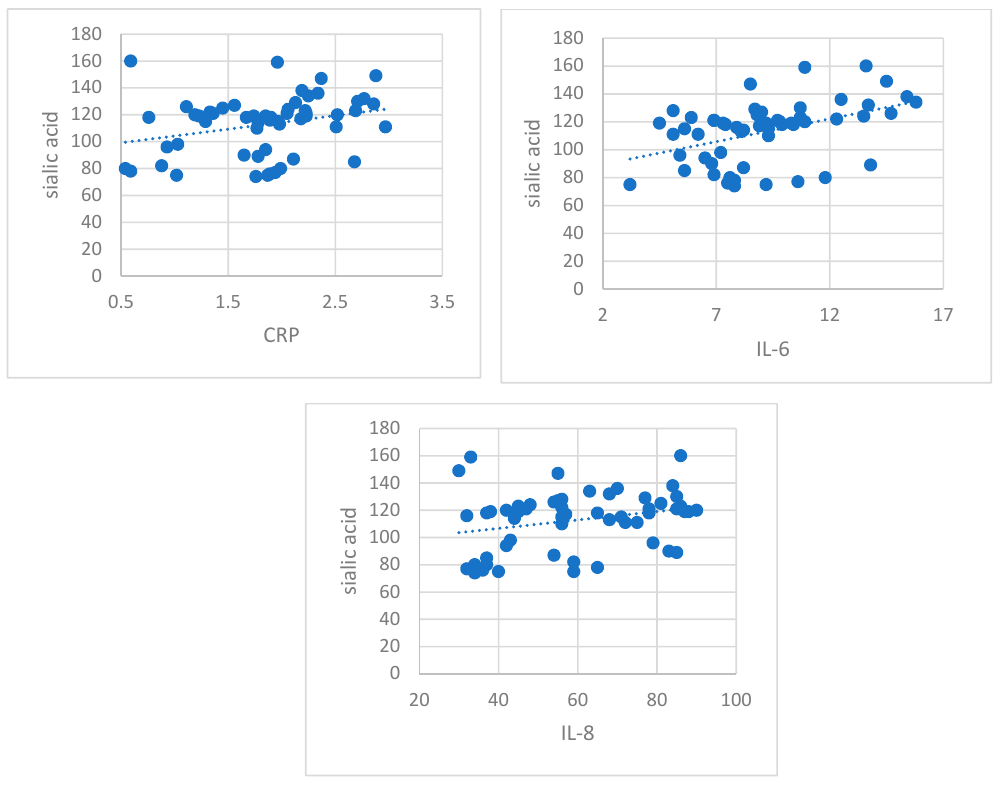
Figure A1. Sialic acid and CRP, IL-6, and IL-8.